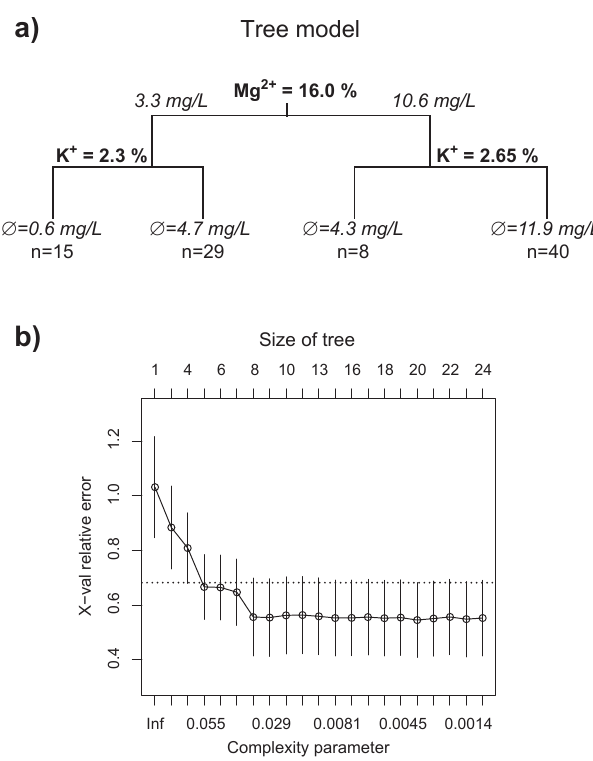
Figure 6. Univariate tree model (UTM) explains variability pattern in DOC concentration. (a) The tree model focuses on DOC concen- tration as response variable. The UTM uses 92 observations and a set of 22 explanatory variables. Mg 2 + and K + ions are most im- portant to explain differences in DOC concentrations. Mean DOC concentrations of each group in mgL − 1 . Number of observations in each group ( n ). (b) Cross validation determines the statistically significant size of the tree model. The dotted line is obtained by the mean value of the errors ( x error) of the cross validations plus the standard deviation of the cross validations upon convergence. For individual sample values see Table